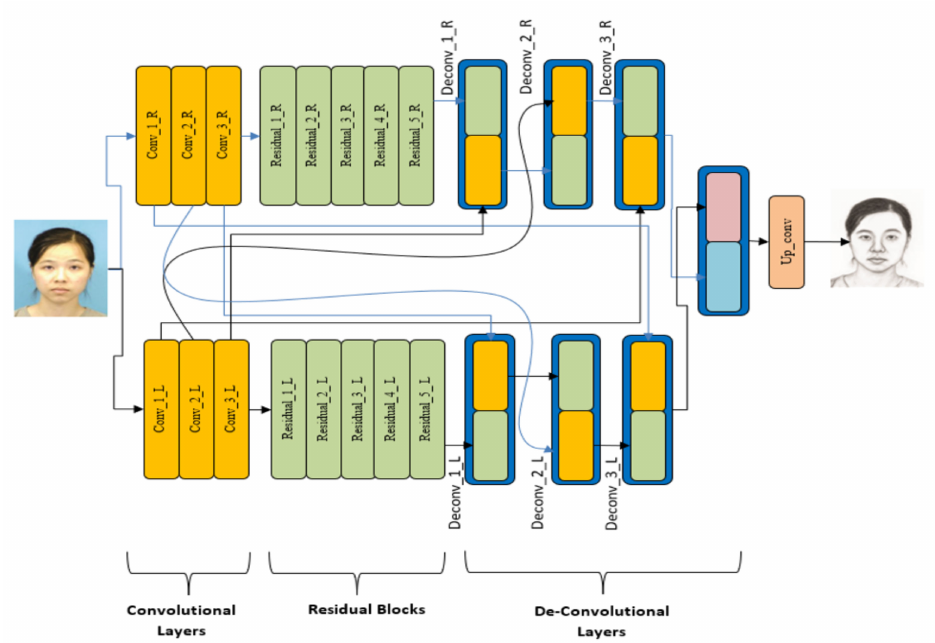
Figure 2. Architecture of Spiral-Net as a sketch compilation